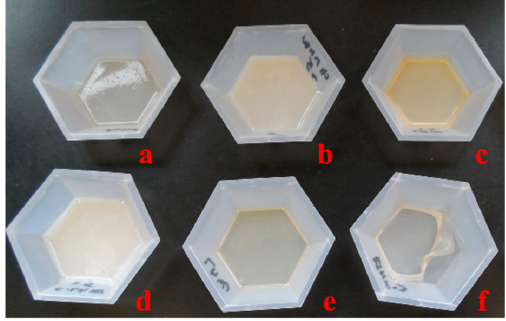
Figure 1. Macroscopic images of films: ( a ) CS-S1 (chitosan-sulfametoxydiazine); ( b ) CS-S2 (chitosan-sulfadiazine); ( c ) CS-S3 (chitosan-sulfadimethoxine); ( d ) CS-S4 (chitosan-sulfamethoxazol); ( e ) CS-S5 (chitosan-sulfamerazine); and ( f) CS-S6 (chitosan-sulfizoxazol).